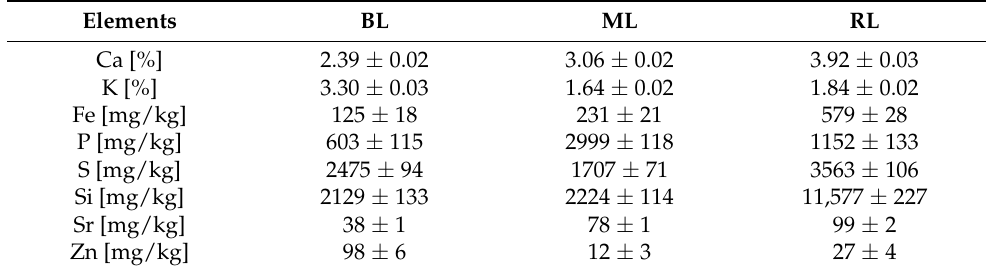
Table 2. Content of inorganic